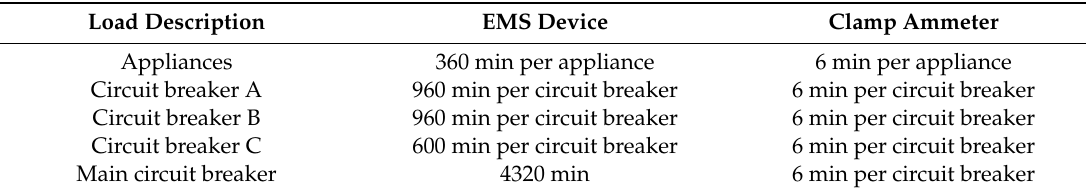
Table 3. The total testing time for each electrical